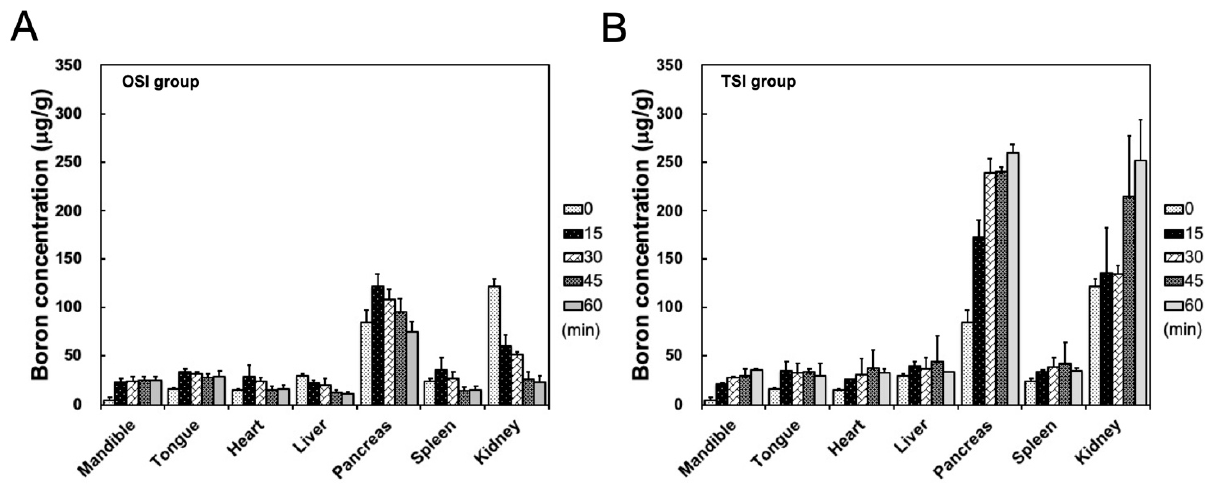
Figure 4. Biodistribution in organs was shown from 20 to 80 min in ( A ) one-step infusion (OSI) and ( B ) two-step infusion (TSI) groups. Data were expressed as the mean ± standard deviation.